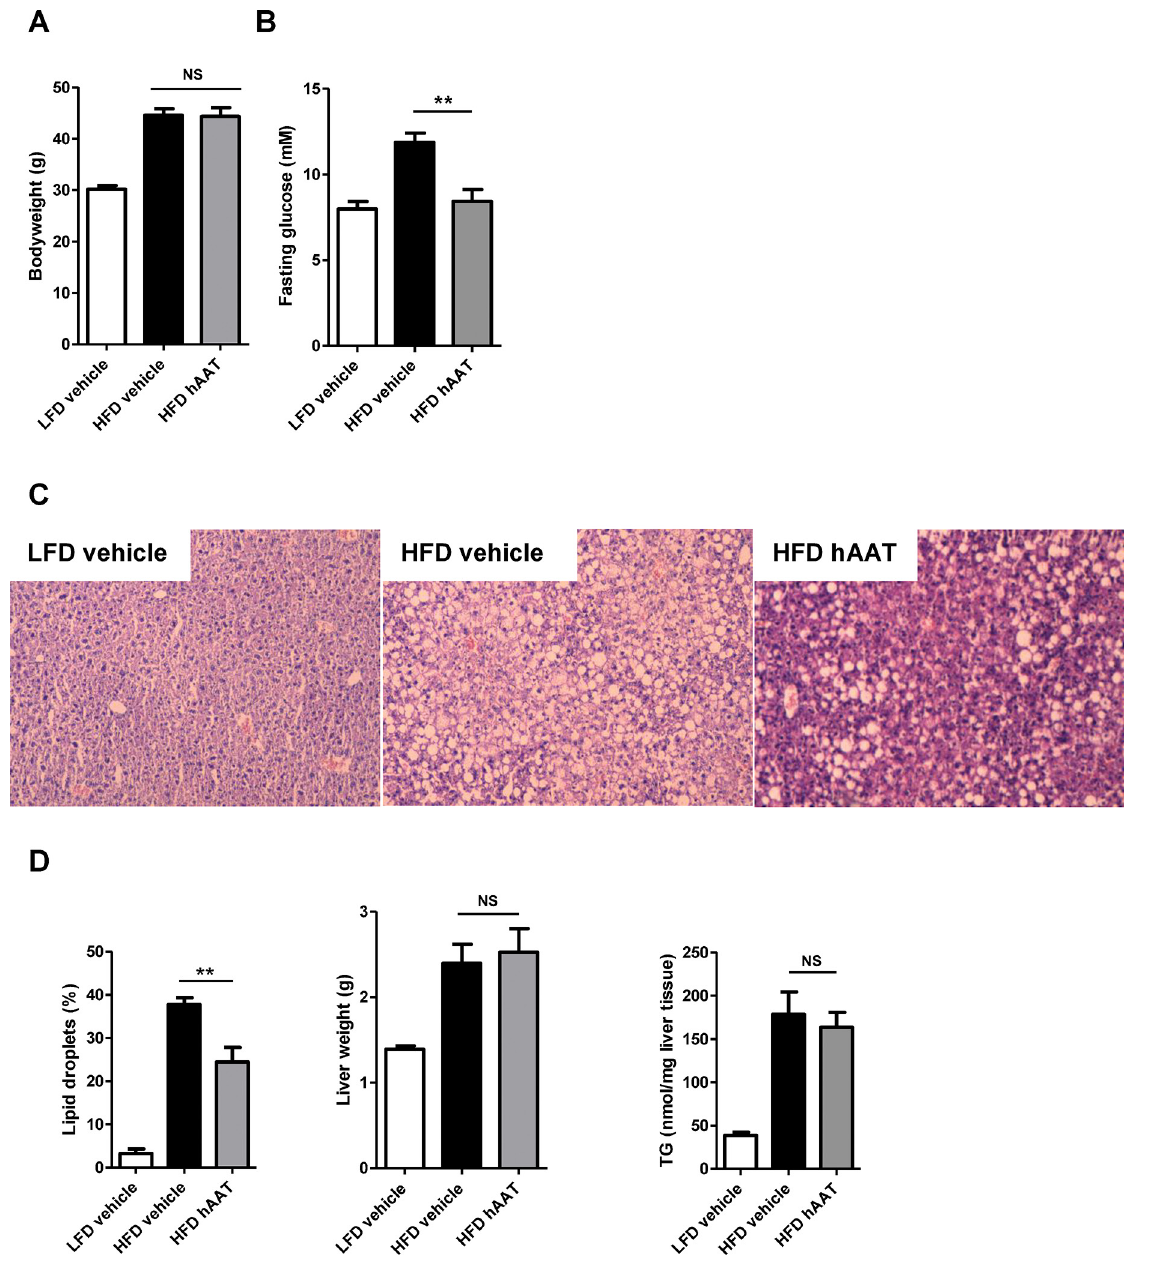
Figure 6. Treatment with α -1 antitrypsin improves NAFLD status and reduces fasting glucose during the last 10 d of a high-fat diet. (A) Bodyweight of mice after a low-fat diet and treated with vehicle and after a high-fat diet treated with either vehicle or α -1 antitryp- sin. (B) Fasting glucose levels. (C) HE staining of liver sections. (D) Percentage of lipid droplets in HE-stained liver sections, liver weights and liver triglycerides. LFD, low-fat diet; HFD, high-fat diet; hAAT, human α -1 antitrypsin; TG, triglycerides; **significant difference p ≤ 0.01; ***significant difference p ≤ 0.001; NS,